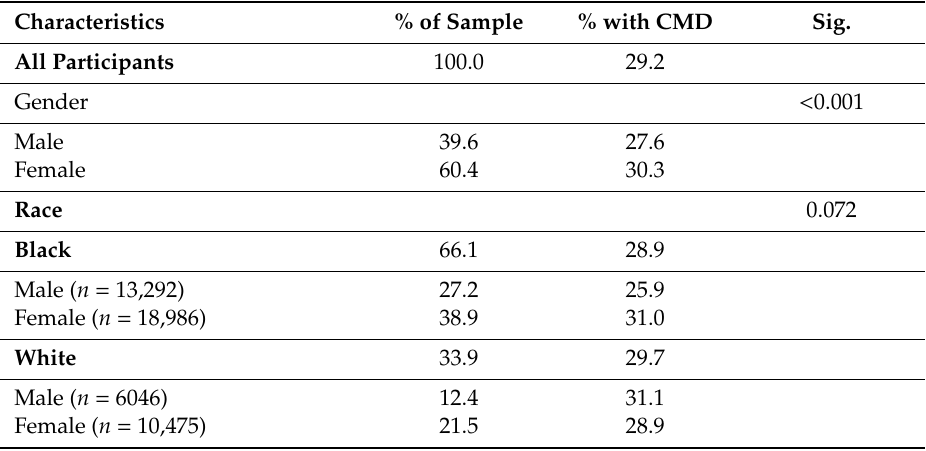
Table 2. Characteristics of the sub-cohort of Southern Community Cohort Study ( n = 48,799).